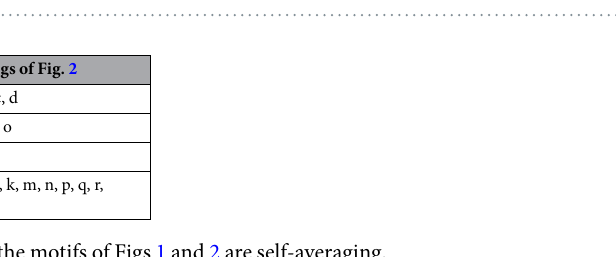
Figure 3. Typical scaling of the number of motifs on three or four vertices in n . The vertex color indicates the dominant vertex degree.